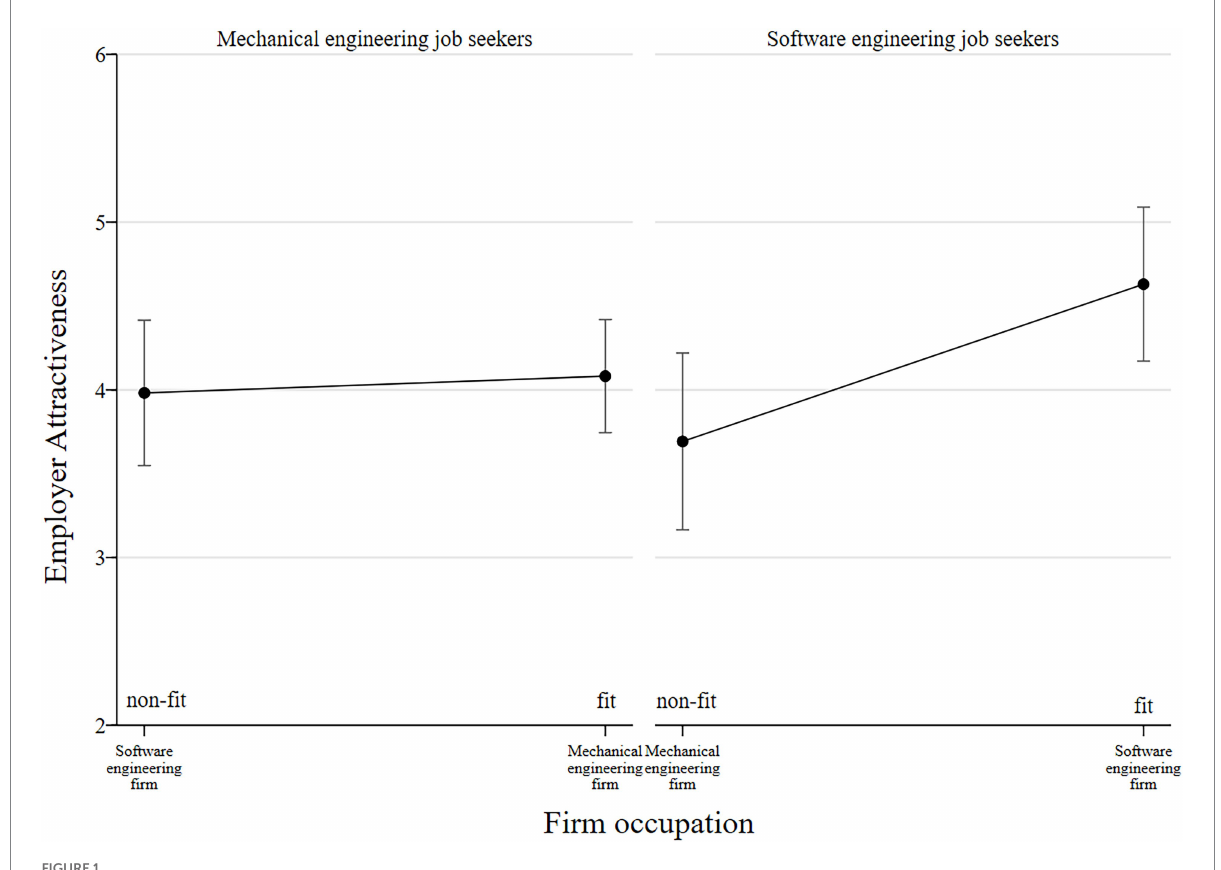
FIGURE 1 Interaction between firm occupation and job seeker occupation with 95% confidence intervals (Model